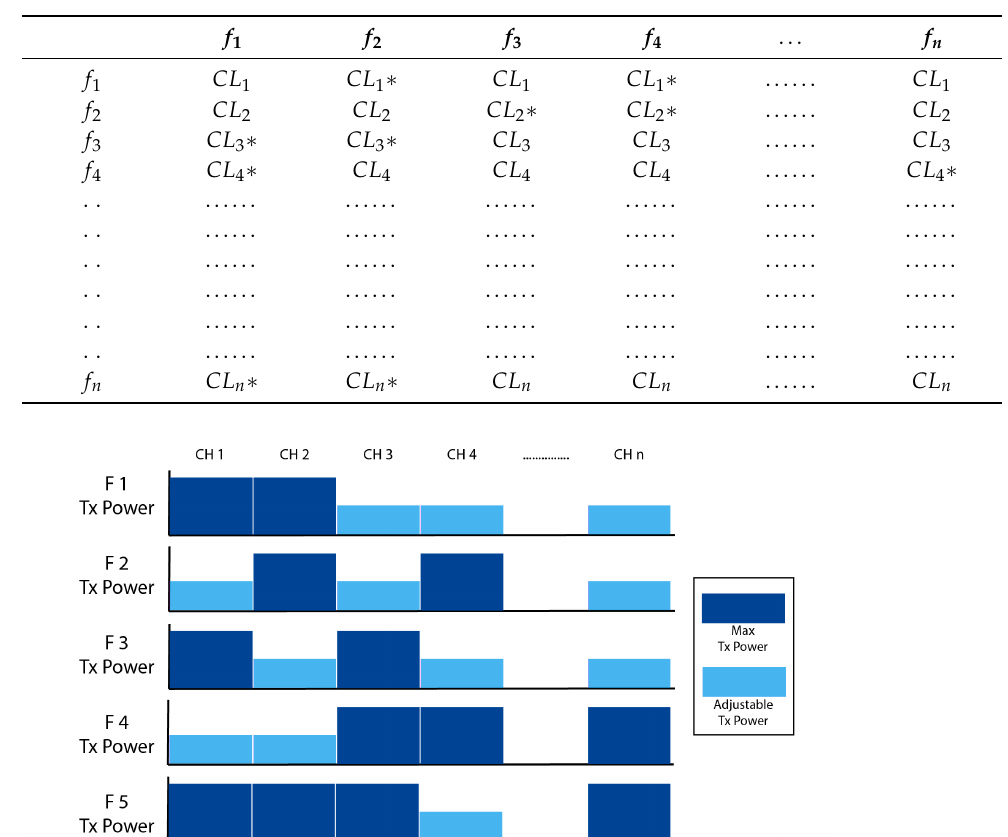
Table 4. Interference-based table.